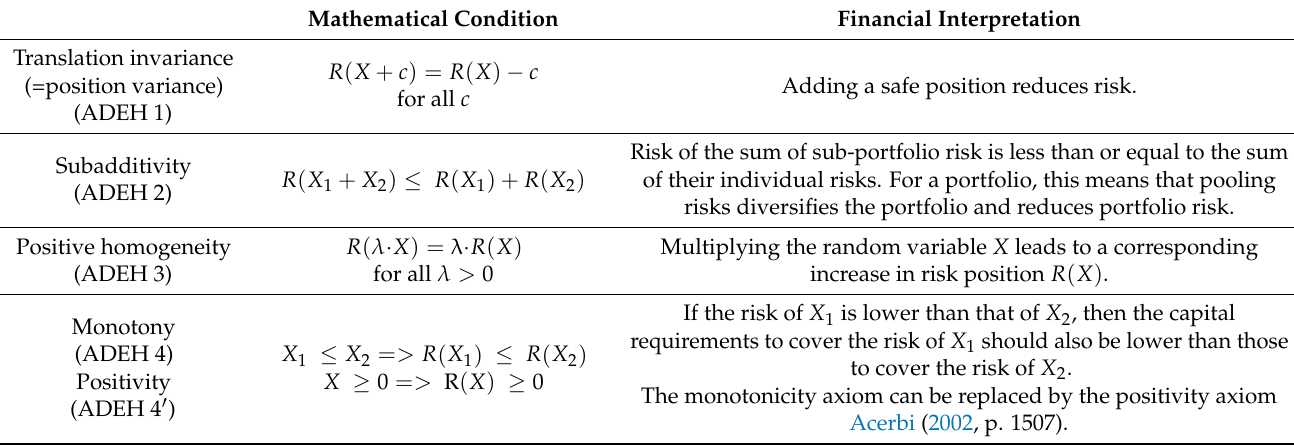
Table 2. Coherent risk measures according to Artzner, Delbaen, Eber, and Heath. Mathematical Condition Financial